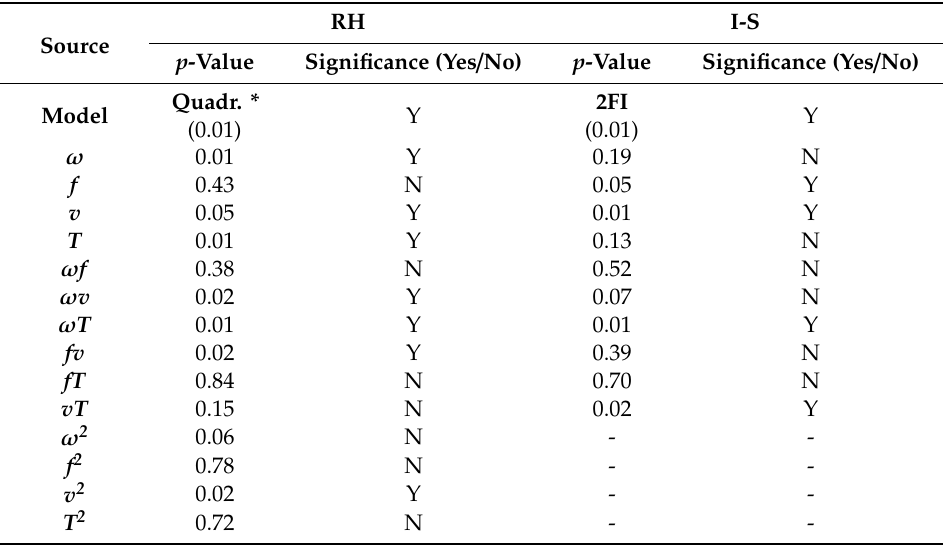
Table 5. Analysis of variance ( ANOVA) Results.